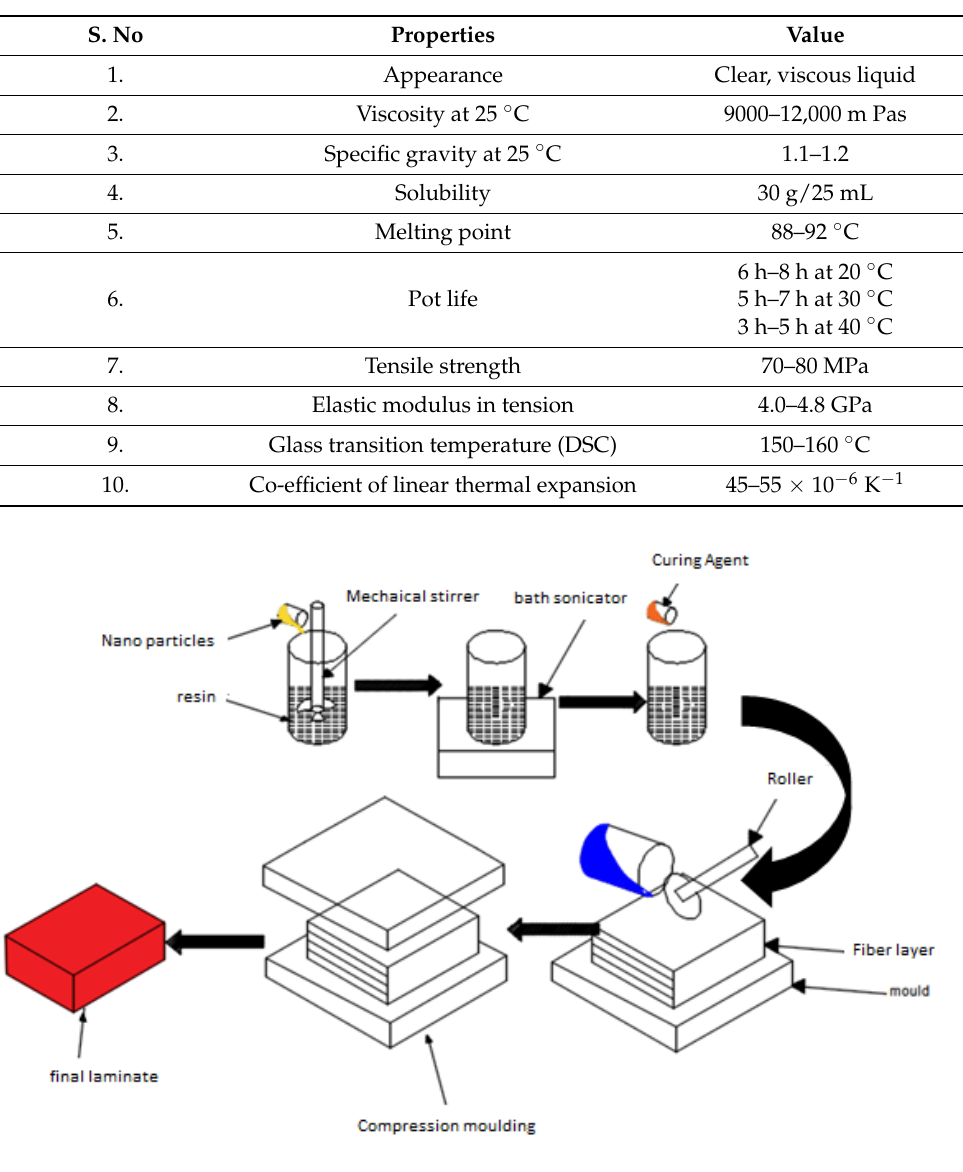
Figure 1. Schematic view of the fabrication of modified nano-polymer